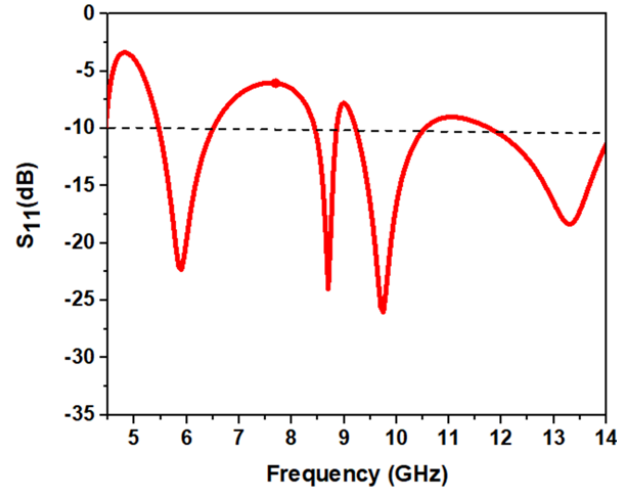
Figure 12. Front ( a ) and rear ( b ) view of Decagonal Sierpinski fractal antenna.